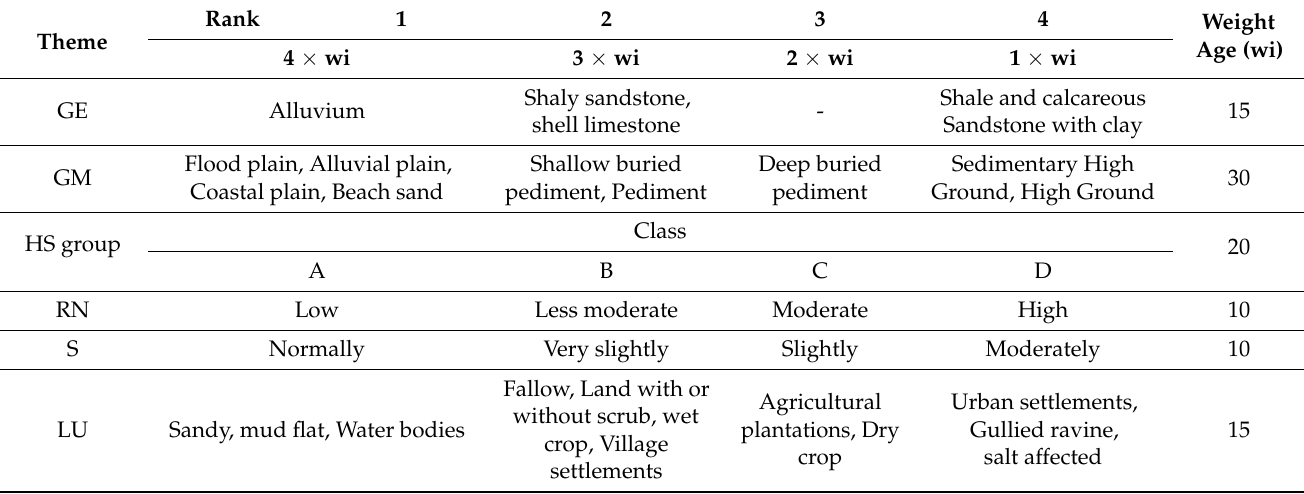
Table 4. Criterion table for identifying suitable artificial recharge sites